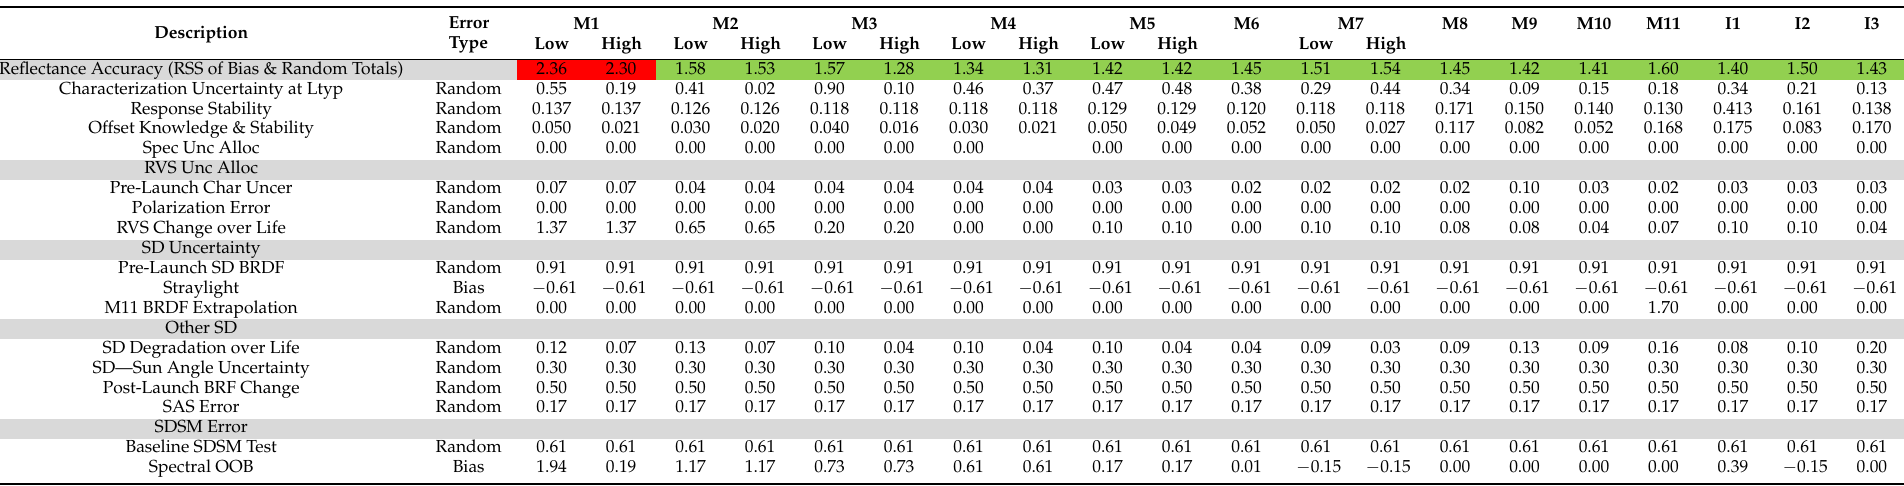
Table 7. A breakout of the reflective solar band calibration uncertainty tree for each component as well as a total rollup (highlighted in green for pass and red for fail). The gray rows are headers with the rows below them the uncertainties associated with that item. Band M1 fails due to high uncertainty in the SDSM OOB spectral leak and the RVS change over the